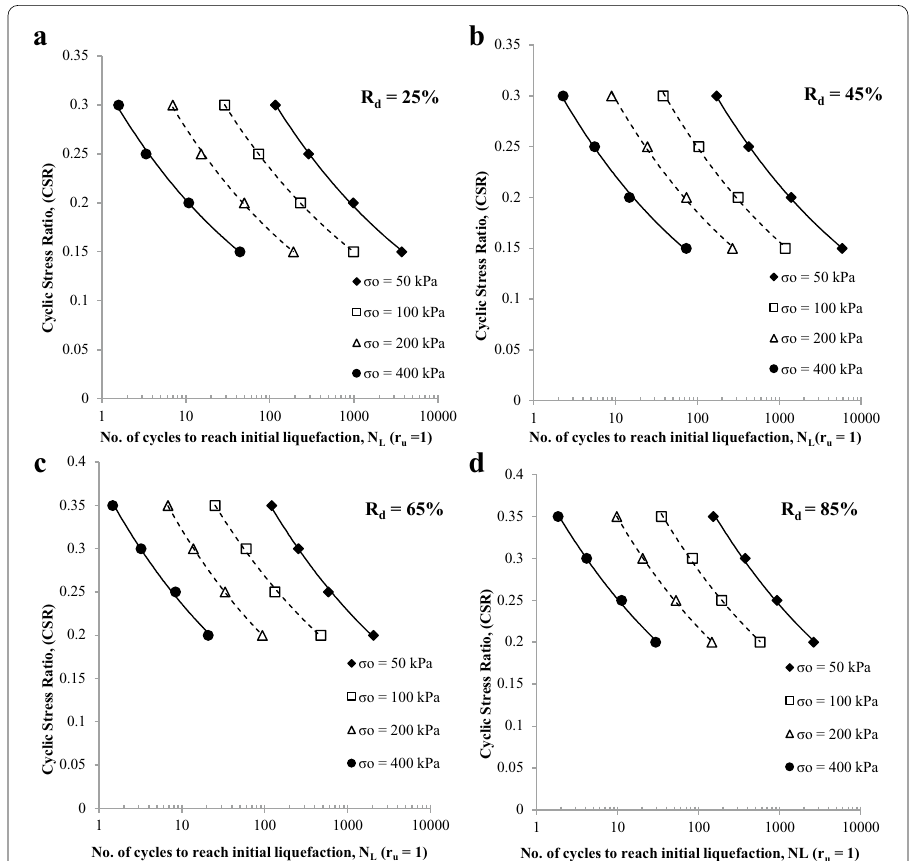
Fig. 12 Variation of cyclic stress ratio with number of cycles to reach initial liquefaction by varying confining pressures from 50 kPa to 400 kPa at a R d